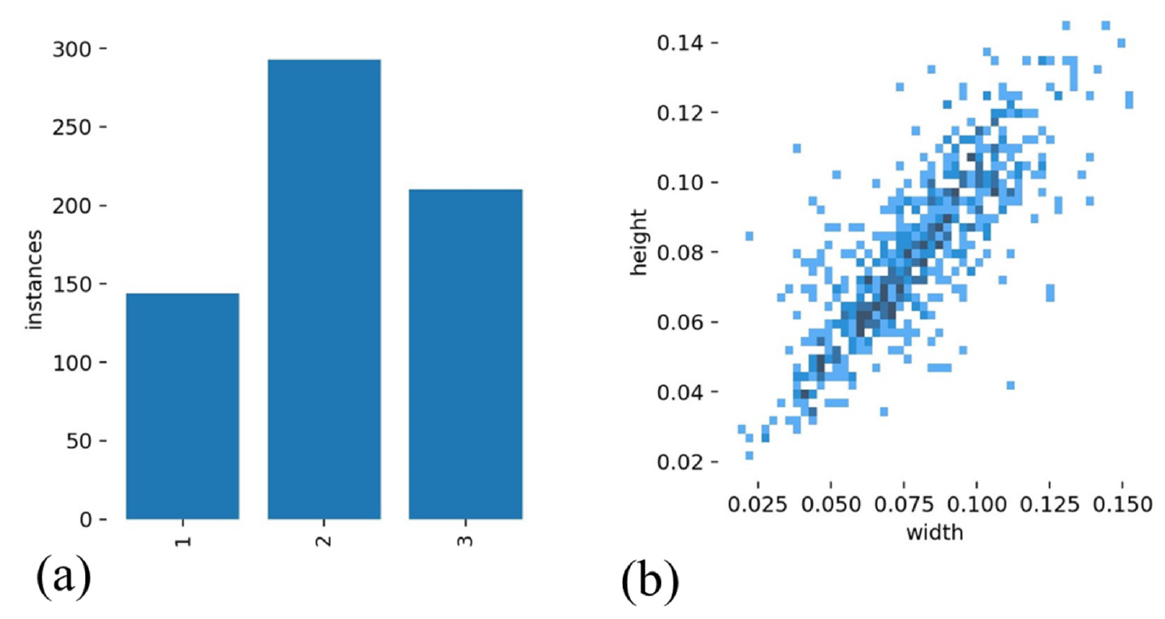
Figure 6. The dataset class representation ( a ) and annotation size plot ( b ).